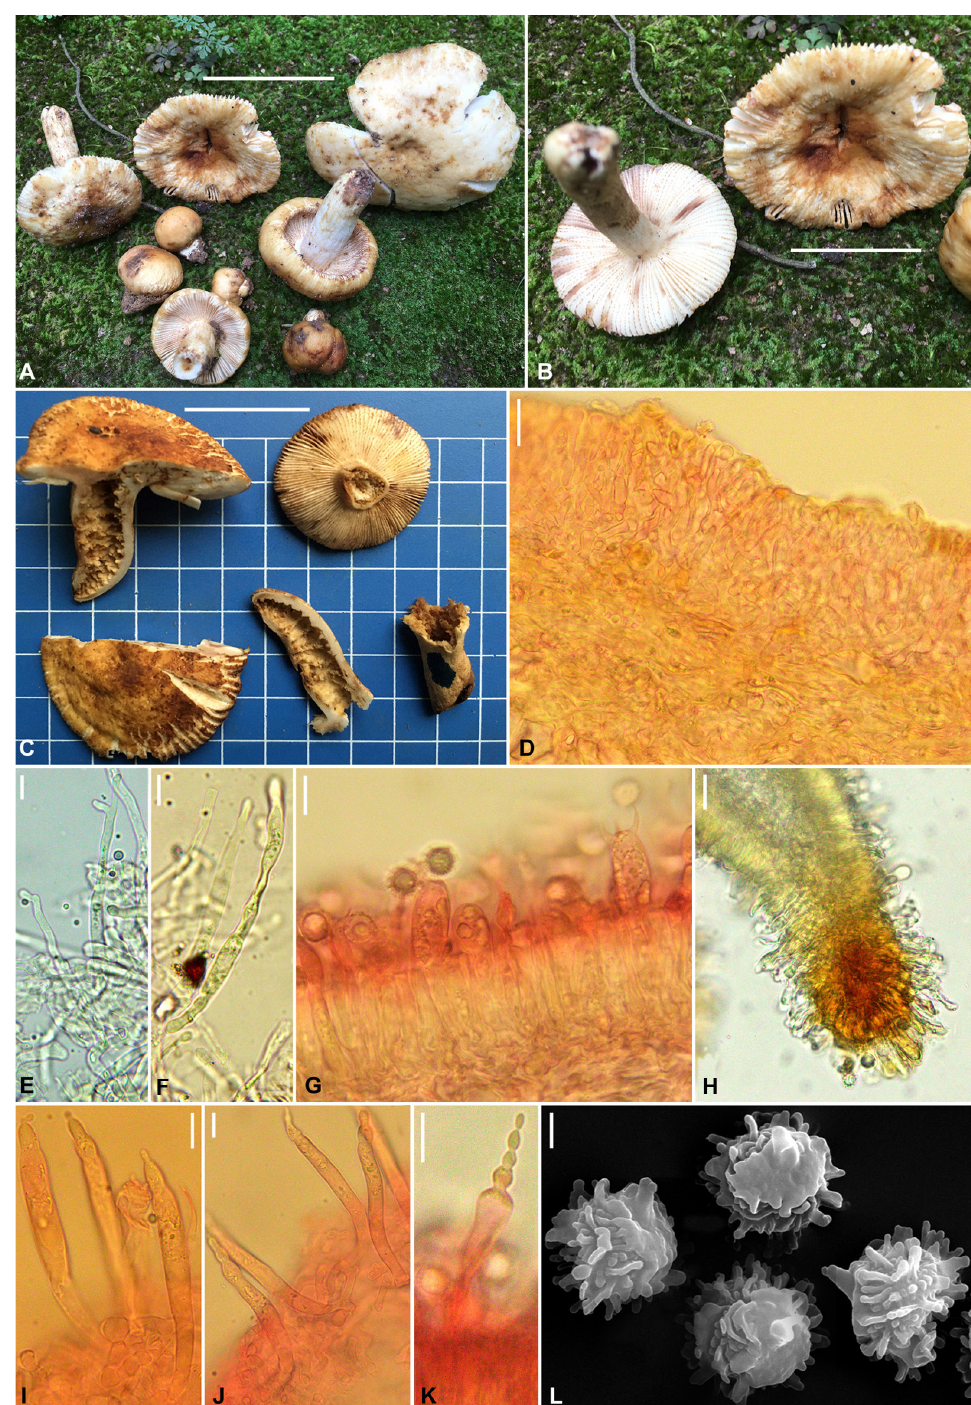
Fig. 5. Russula pseudosenecis A.Ghosh, D.Chakr., K.Das & Buyck sp. nov. (from holotype, AG 20- 062 ). A–C . Fresh and dissected basidiomata in the field and basecamp. D–F . Transverse section through pileipellis showing elements. G . Transverse section through lamellae showing basidia. H . Transverse section through lamellae showing hymenial cystidia near the lamellae edges. I−K . Transverse section through lamellae showing hymenial cystidia near the lamellae sides. L . SEM micrograph of basidiospores showing the uplifted (and thus strongly amyloid) suprahilar plage. Scale bars: A−C = 30 mm; D, H = 20 μm; E−G, I−K = 10 μm; L= 2